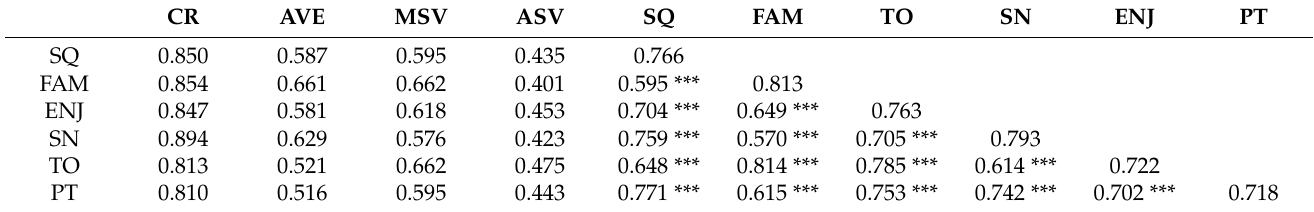
Table 4. Correlation matrix of the